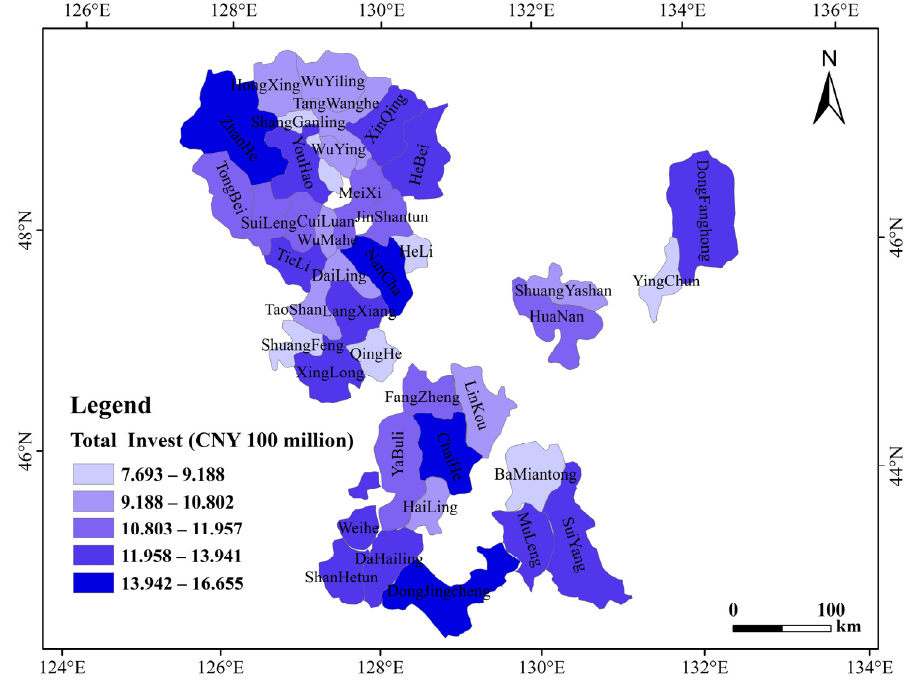
Figure 6. Temporal change in FMI in key SOFRs in Heilongjiang Province.